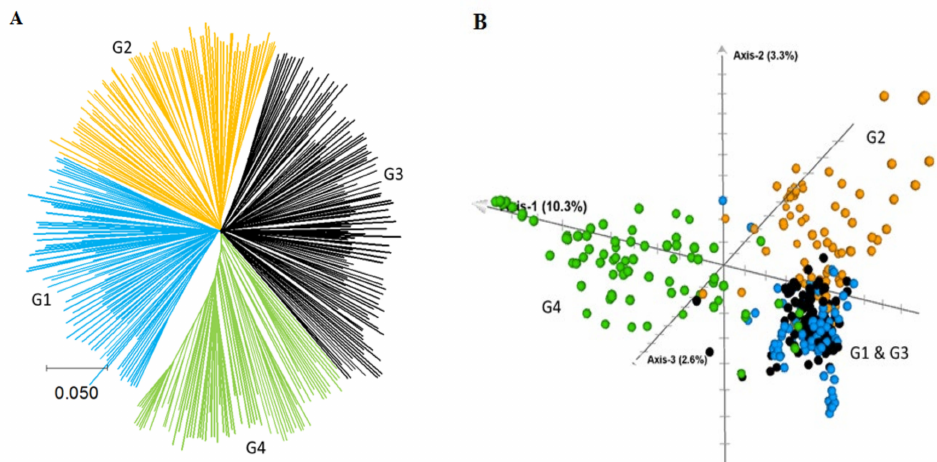
Figure 5. Neighbour-joining tree and multidimensional scaling (MDS) analysis of 384 maize inbred lines based on genetic distance matrix computed from 60,227 polymorphic SNP markers in TASSEL v 5.2. NJ tree ( A ) and MDS ( B ) were constructed using MEGA v11 and CurlyWhirly v1.21.08.16,